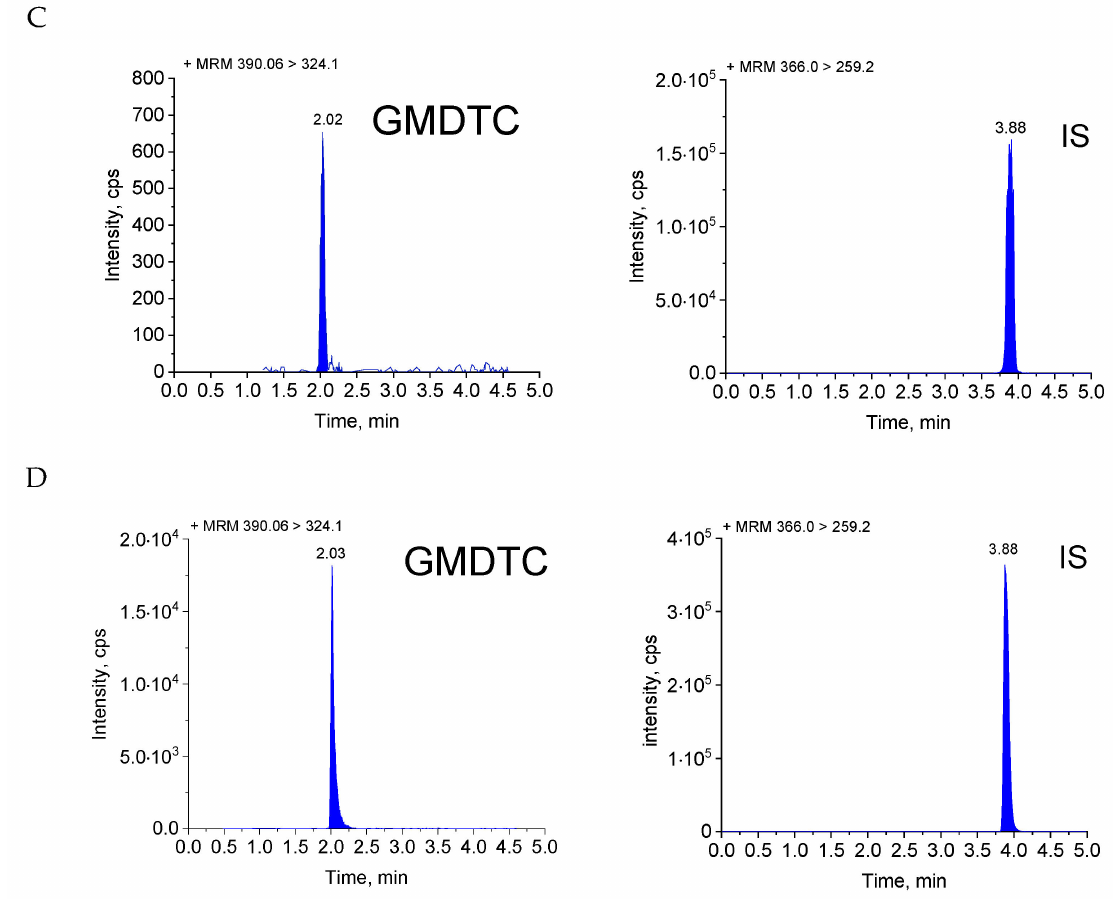
Figure 1. Chemical structures and typical MRM chromatograms of GMDTC (left, m / z 390.06 → 324.1) and IS (right, m / z 366.0 → 259.2). ( A ) Chemical structures of GMDTC and metolazone, ( B ) blank rat plasma, ( C ) blank rat plasma spiked with GMDTC (LLOQ, 50 ng/mL) and IS (at the level of use, 50 ng/mL), ( D ) plasma sample taken 0.133 h after injection administration of 50 mg/kg GMDTC to the